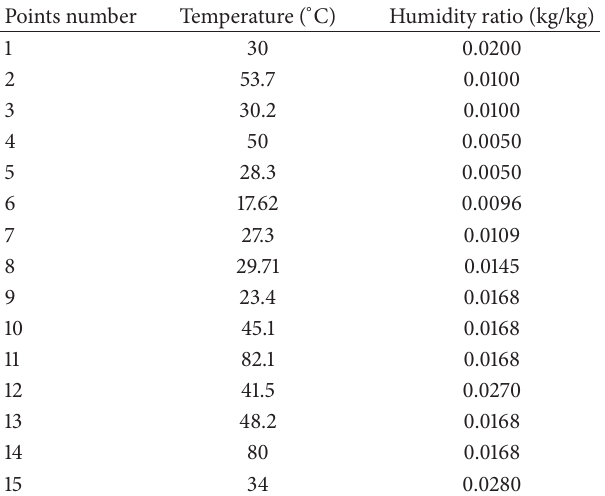
both modes are almost the same. In addition, the room temperatures under